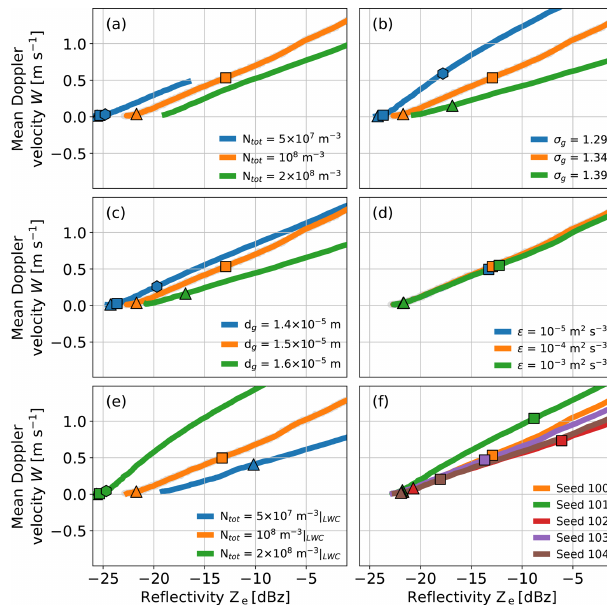
Figure 2. As in Fig. 1 but for mean Doppler velocity W